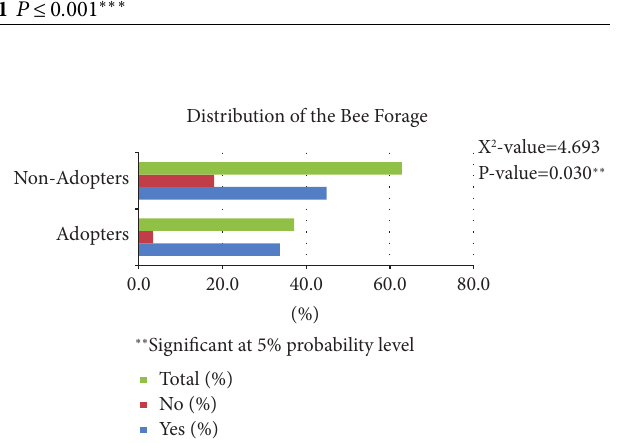
Figure 3: Distribution of the bee forage status (source: own survey data, 2016). ∗∗ Significant at 5% probability